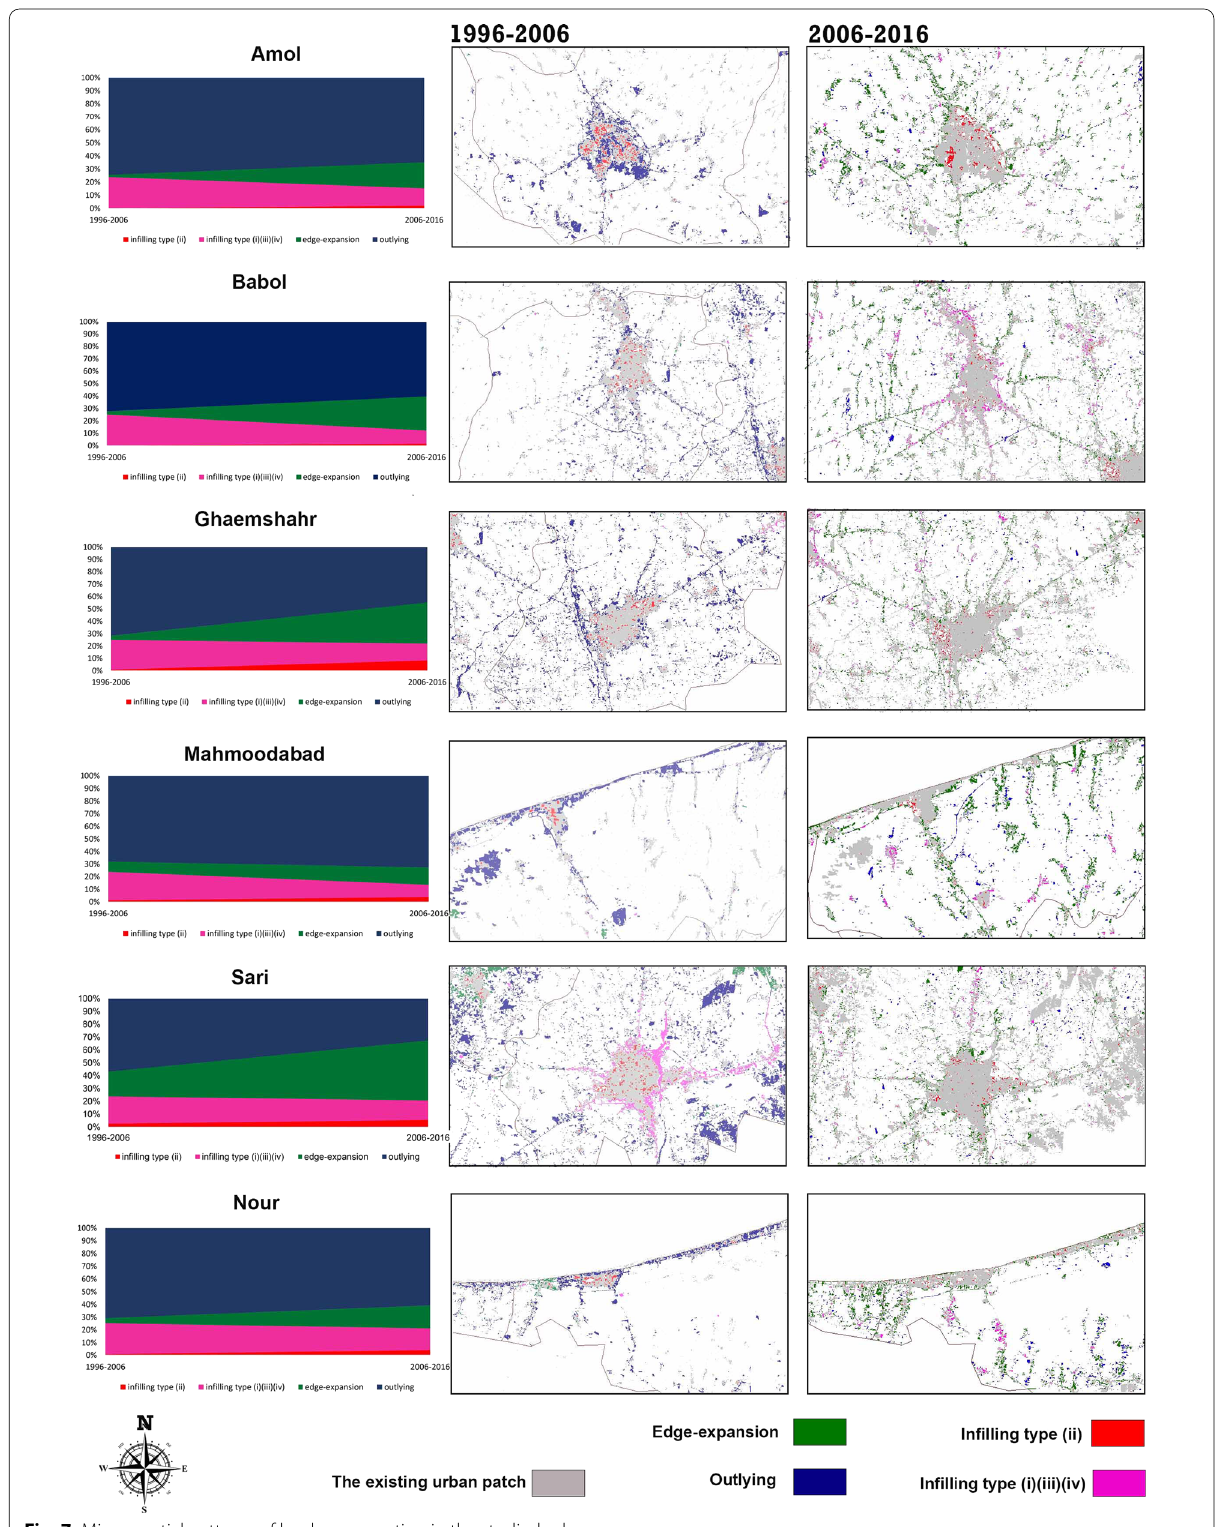
Fig. 7 Micro-spatial patterns of land consumption in the studied urban